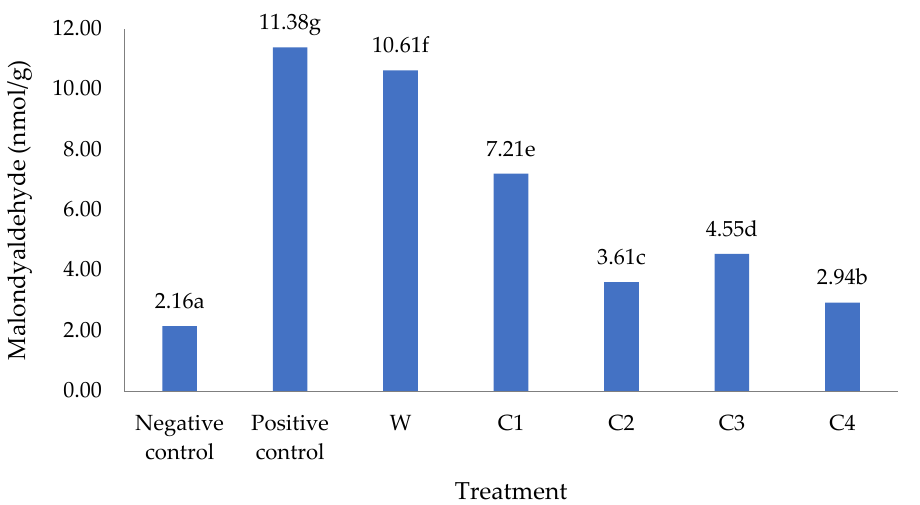
Figure 2. Malondialdehyde levels in diabetic Wistar rats after four weeks of feeding. Note: Negative control = non-diabetic rats; positive control = diabetic rats with normal diets; W = diabetic rats on wheat cookies diet; C1 = diabetic rats on C1 diet (corn cookies containing granulated sugar and margarine); C2 = diabetic rats on C2 diet (corn cookies containing crystalline coconut sugar and margarine); C3 = diabetic rats on C3 diet (corn cookies containing granulated sugar and VCO); C4 = diabetic rats on C4 diet (corn cookies containing crystalline coconut sugar and VCO). Different letters behind the numbers indicate a significant difference at the 5%